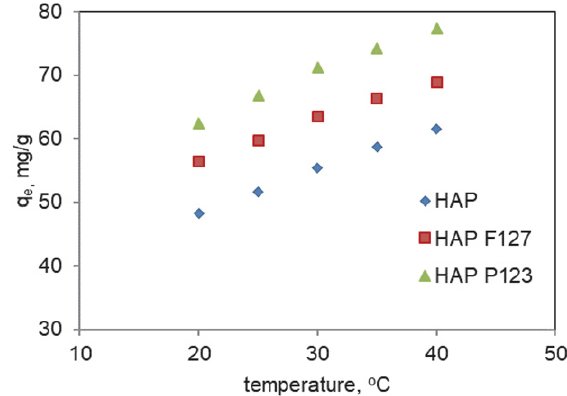
Figure 6. Dependence of adsorption process of Al(IIII) ions on the